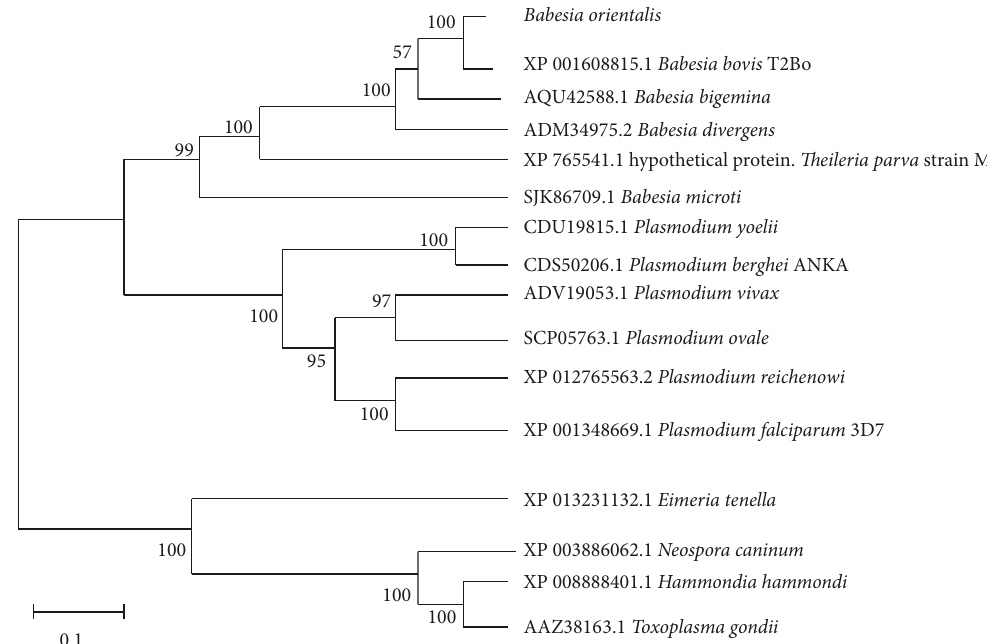
Figure 2: Relationship of BoRON2 with other apicomplexan related RON2 proteins . The neighbor joining tree was constructed using protein sequence of Babesia orientalis RON2 with its homologues found in NCBI, and the respective accessions numbers are indicated. The scale bar shows the length of branch; every 0.1 nucleotides’ difference per 100 is represented. B. orientalis RON2 is in the same clade with B. bovis , B. bigemina , and B. divergens , more close to B. bovis .